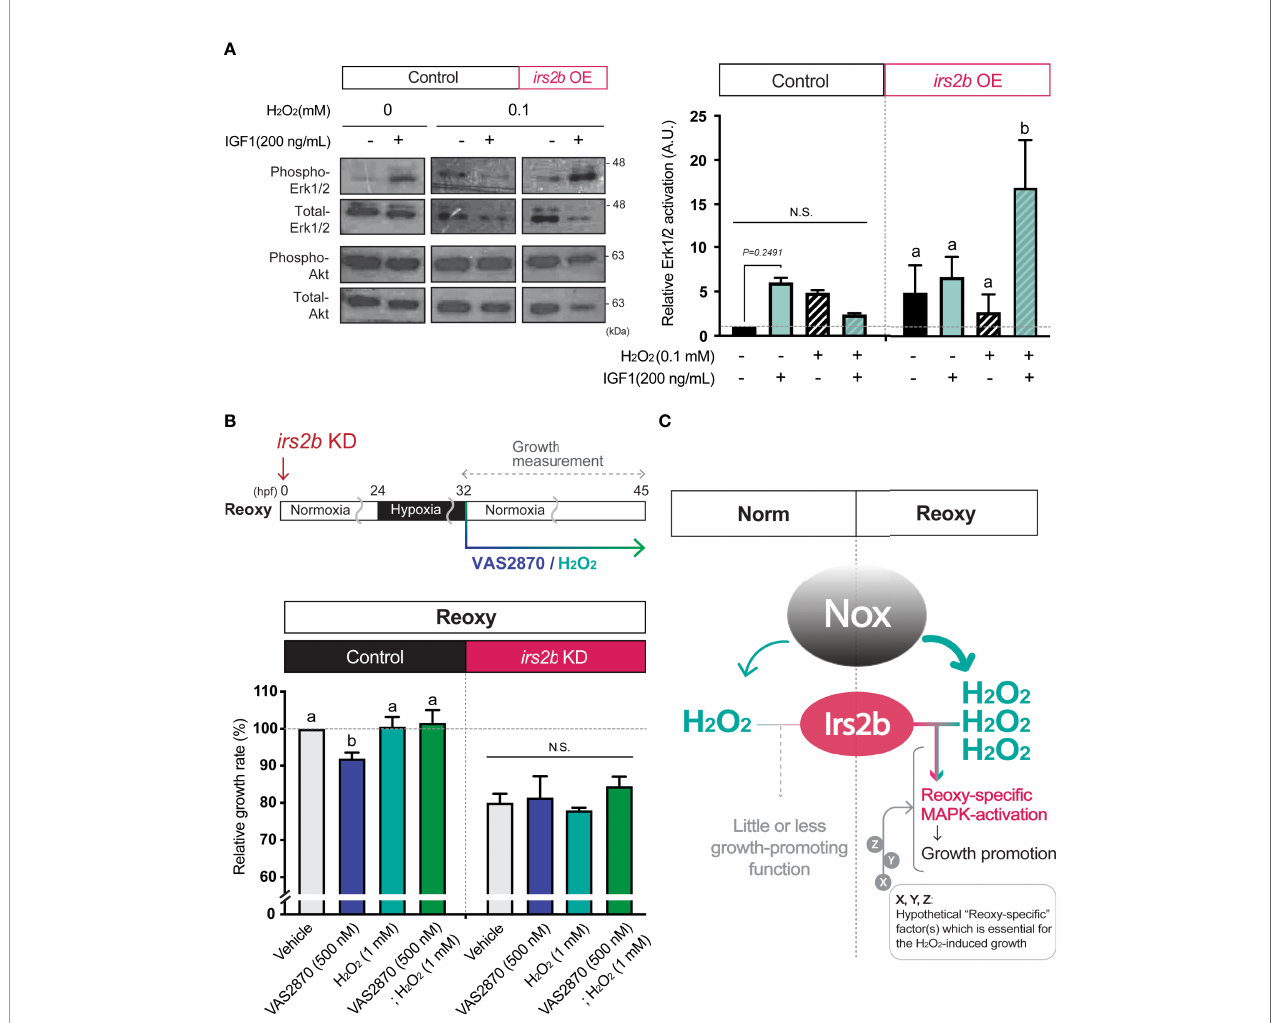
FIGURE 7 | Irs2b mediates H 2 O 2 -dependent Erk1/2-phosphorylation and catch-up growth. (A) Immunoblot analysis of the IGF1 (200 ng/mL) -induced phosphorylation levels of Erk1/2 in the presence or absence of H 2 O 2 and Irs2b in HEK293T cells. Cells harboring the irs2b overexpression ( irs2b OE) or not (control) were used. Data are mean ± SE of 2 independent experiments. Values marked with different letters (a, b) are signi fi cantly different from each other (N.S. means not signi fi cantly different ( P<0.05 ). (B) Changes in the relative growth rate of embryos in the Reoxy (32-45 hpf) embryos treated with or without VAS2870 and H 2 O 2 . Embryos lacking the irs2b expression ( irs2b KD) or control MO injected embryos (Control) were used for experiments. The vehicle alone group was set as 100%. Data are mean ± SE of 3 independent experiments. Values marked with different letters (a, b) are signi fi cantly different from each other ( P<0.05 ). (C) A proposed model. The Nox generates